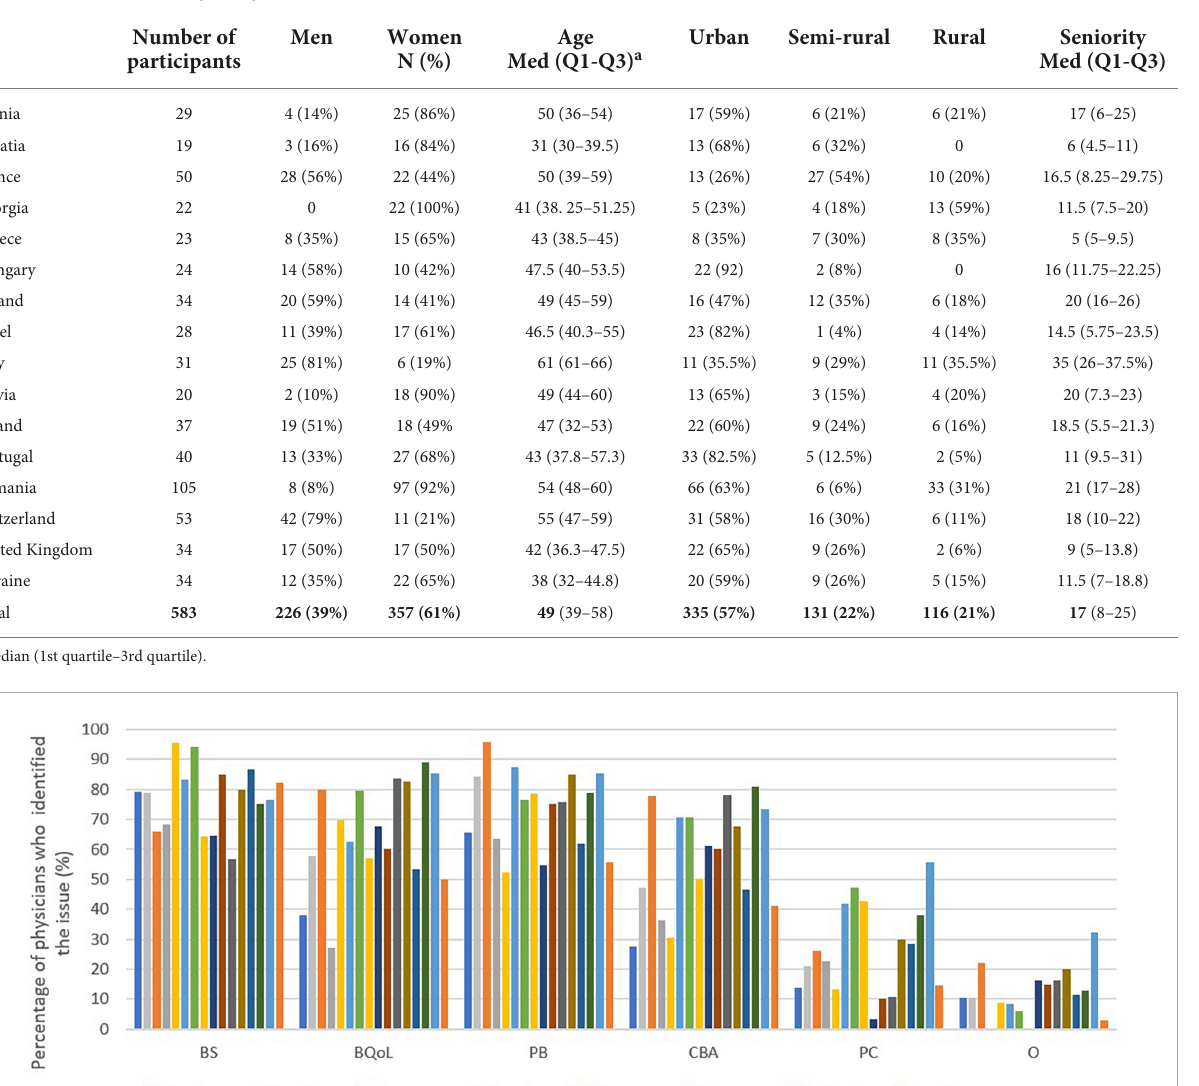
TABLE 1 Characteristics of participants.